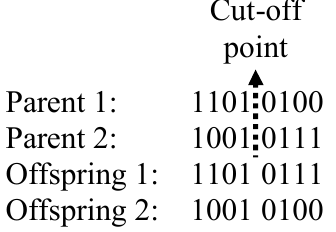
Fig. 1. Crossover